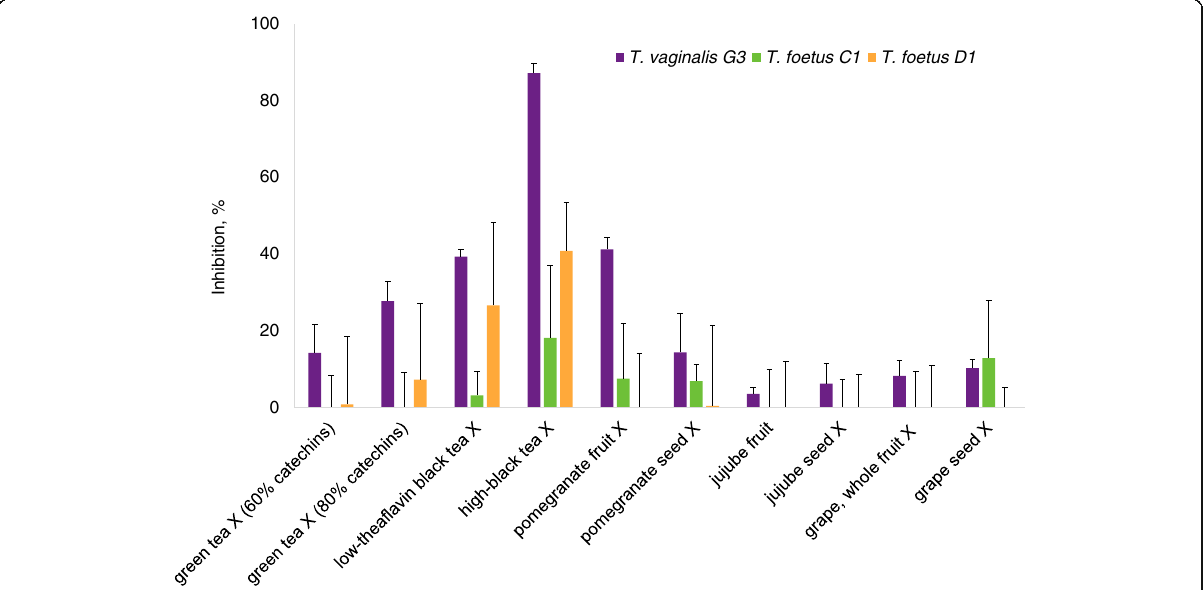
Fig. 1 Inhibitory activity of ten plant preparations with the standard error ( n = 3 or higher) on three different pathogenic trichomonads ( T. vaginalis G3, T. foetus C1, and T. foetus D1). See Table 1 for sample sources. X denotes